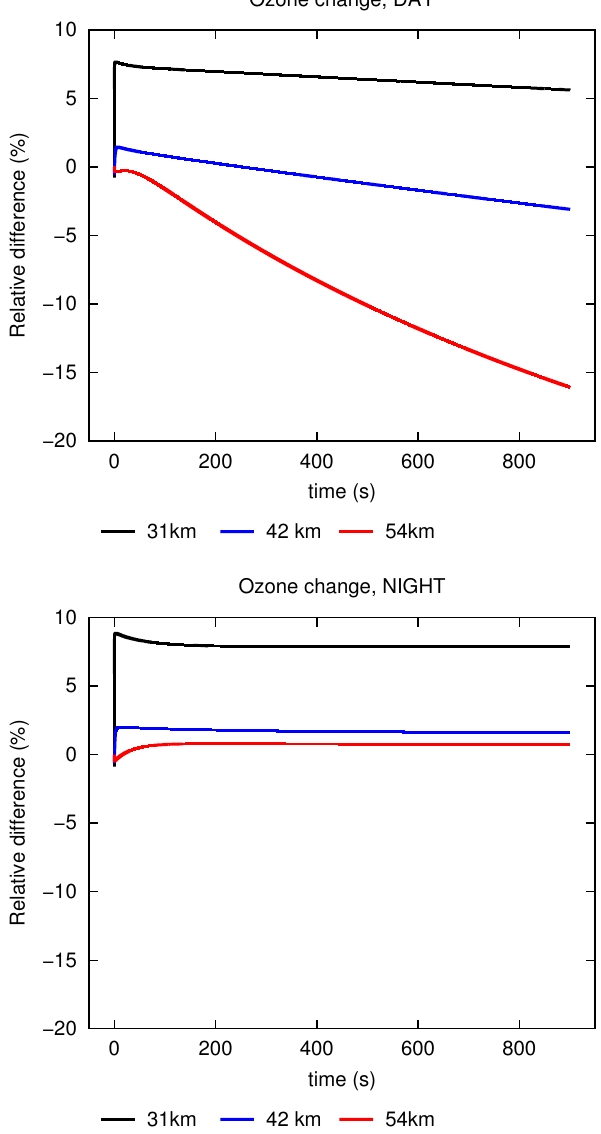
Fig. 8. Modelled change of ozone in sprite streamers at three selected altitudes. Upper panel: daytime; lower panel: nighttime. that the night-time event has basically no effect at 54 km. At 42 km, ozone increases by about 100 ppb in both night-time and daytime streamer. In the daytime case this is followed by a rapid ozone decrease of more than 100 ppb compared to the initial ozone value. At 31 km, the impact of daytime and night-time streamer are very similar; both of them lead to an ozone increase of almost 800